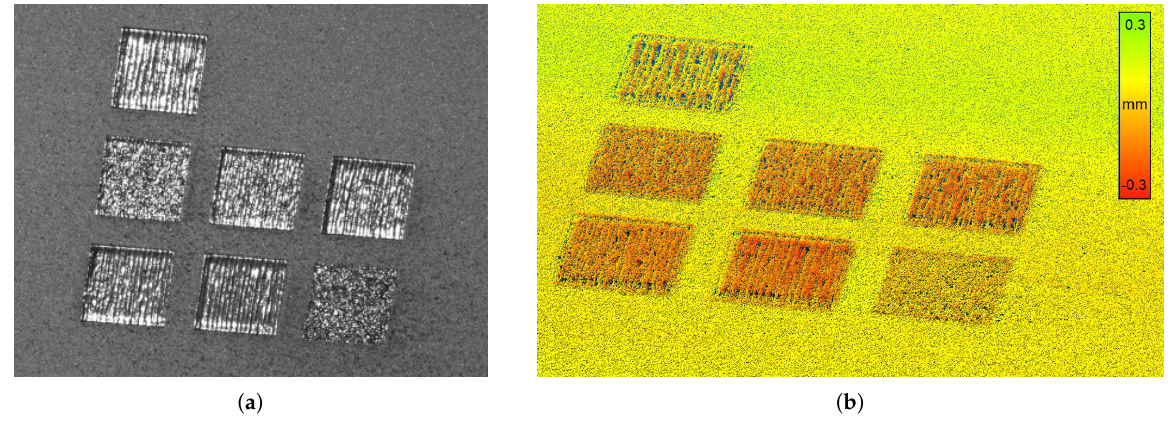
Figure 14. Results of printing depending on process parameters showing melted tracks of layer 10 with a size of 10 × 10 mm. ( a ) Perspective view of one measurement camera. ( b ) Visualized 3D data from the calculated point cloud. The measured geometry values show a high degree of similarity to the image of the camera. For height information, see the color scale. Process and sample parameters are given in Table A1 of Appendix